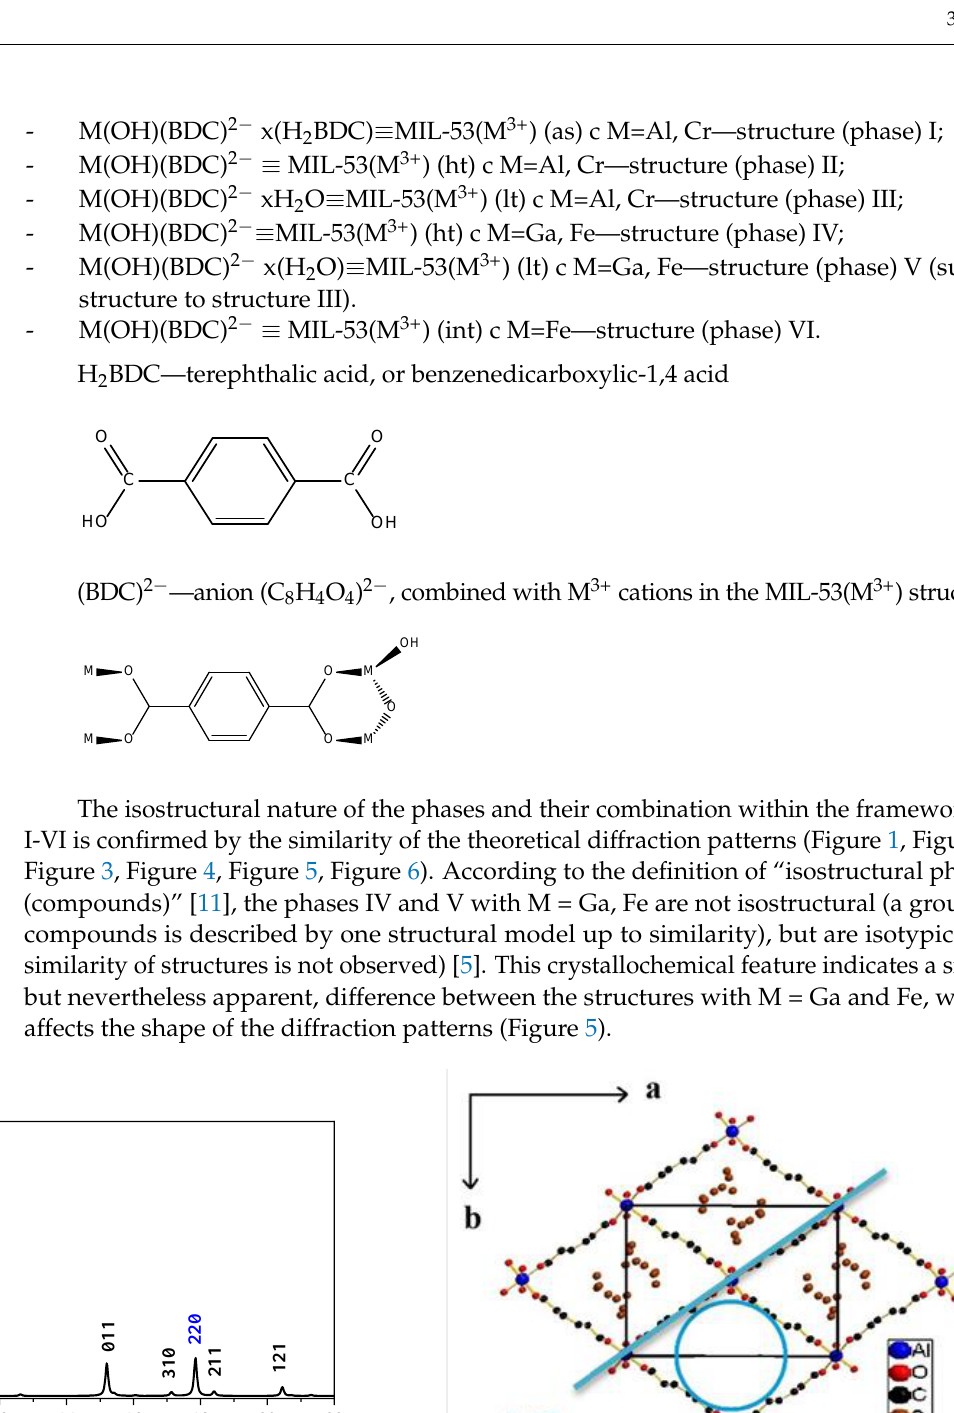
Figure 1. Structure I (sp.gr. Pnam, z = 4): theoretical diffraction pattern ( a ), structure projected onto the ( b ) XY plane.